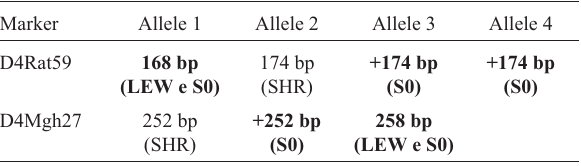
Alleles from 1 to 4 are ordered by size. The populations where each of the alleles was identified are shown in parenthesis. The alleles found in the population S0 are indicated in bold. + means “larger than”.